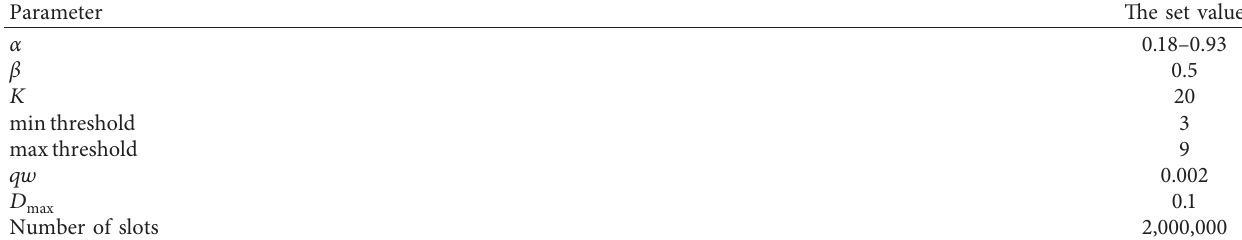
Table 1: Parameter settings of RED, NLRED, and RED_E.